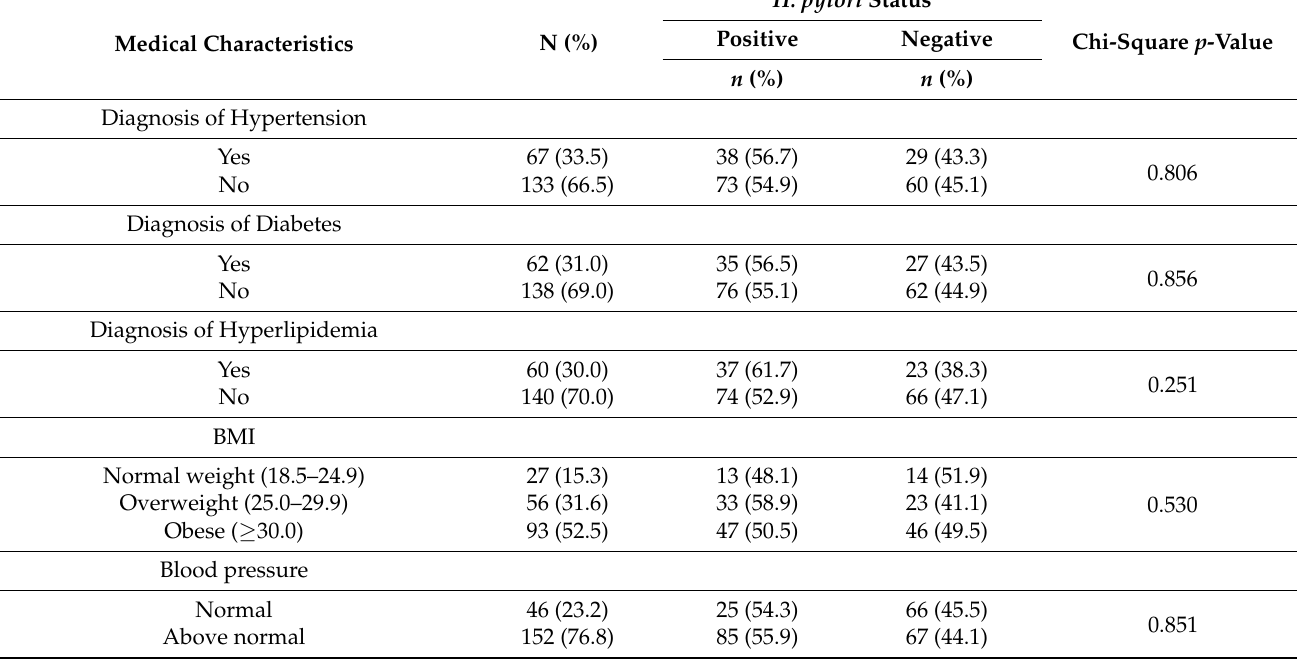
Table 6. Medical condition of the study participants and its association with H. pylori